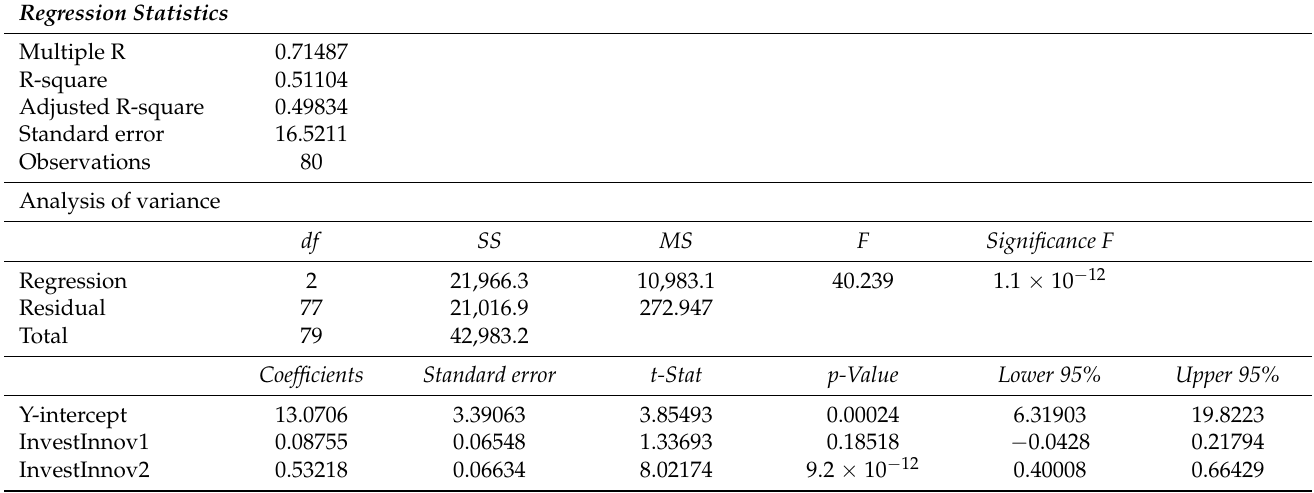
Table A6. Regression statistics of the dependence of Frisk 1 on investments in innovation (InvestIn-